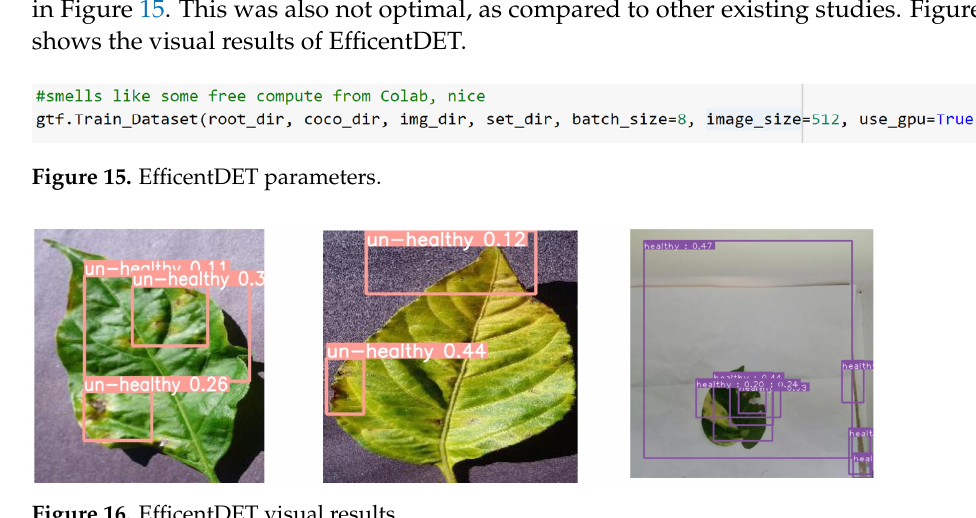
Figure 16. EfficentDET visual